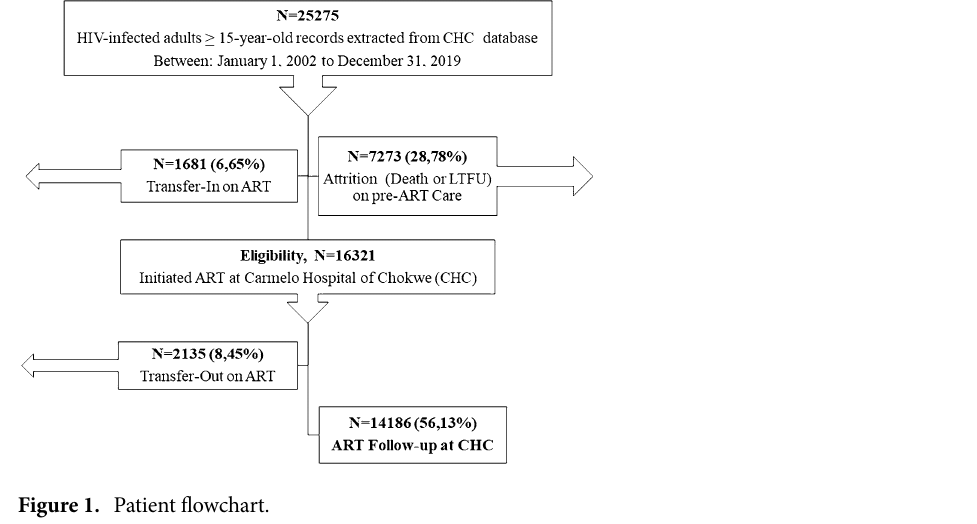
Figure 1. Patient